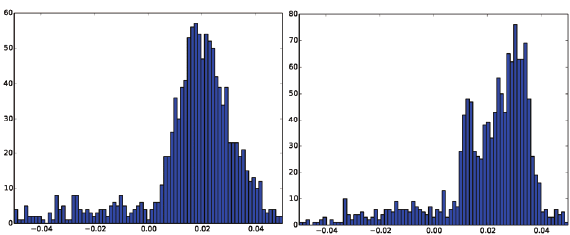
Figure 7. Histogram of deviations between -5 cm and +5 cm before adjustment for scanner 1 (left) and 2 (right).